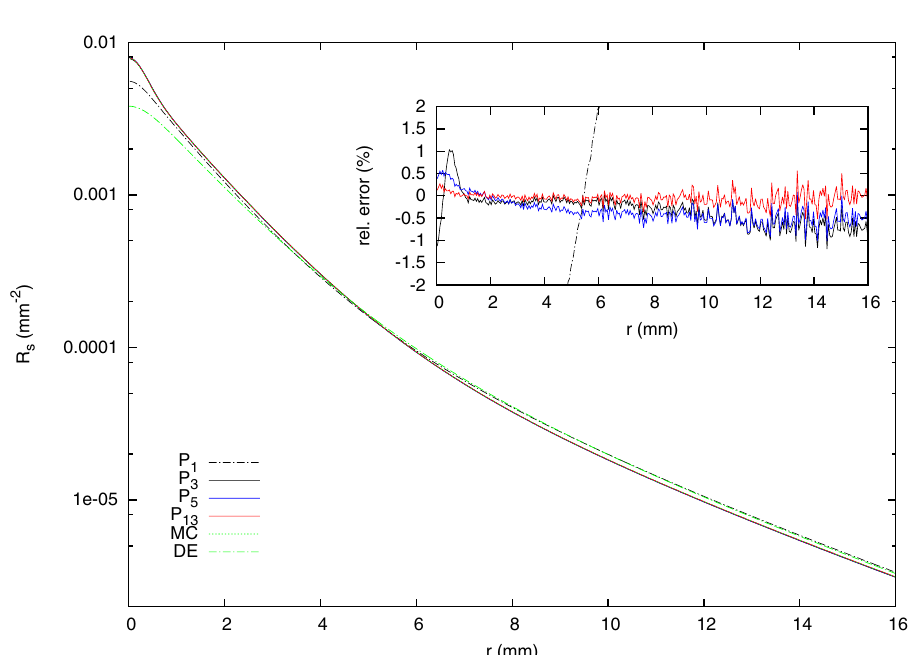
Figure 7. Steady-state spatially resolved fluorescence from the two-layered scattering medium with an upper layer thickness of l = 2 mm. Only the upper layer is fluorescent with a quantum yield of Φ = . 1 0 illuminated by a Gaussian beam with radius ρ w = 0.5 mm. The optical properties of the layers were assigned to the excitation wavelength, whereas those of the fluorescence wavelength were chosen to be 20% below their respective excitation counterparts. The phase function and the boundary conditions are identical for both wavelengths. The P 3 solution already shows a very good agreement with the Monte Carlo simulation. For the Monte Carlo simulation, 8 · 10 9 Photons were